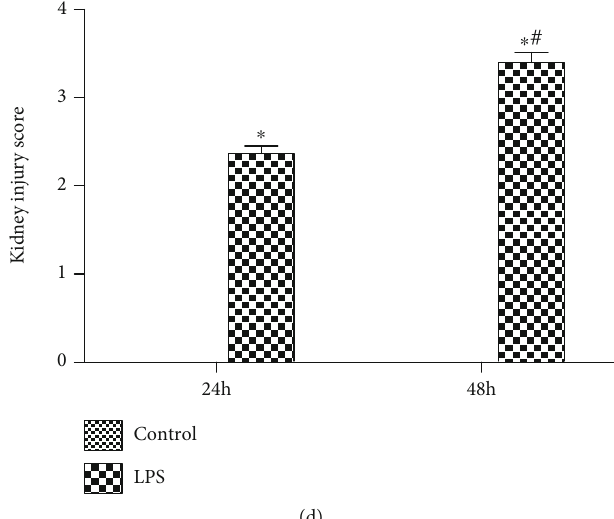
Figure 1: AKI is induced by LPS. (a) The level of BUN in both groups after the LPS challenge. (b) The level of SCr in both groups after the LPS challenge. (c) Representative HE staining in both groups after the LPS challenge. (d) Representative Kidney injury score in both groups. The black arrow indicated injured tubules. Scale bars 50 μ m. ∗ P < 0 : 05 compared with the control group; # P < 0 : 05 compared with the LPS group in 24